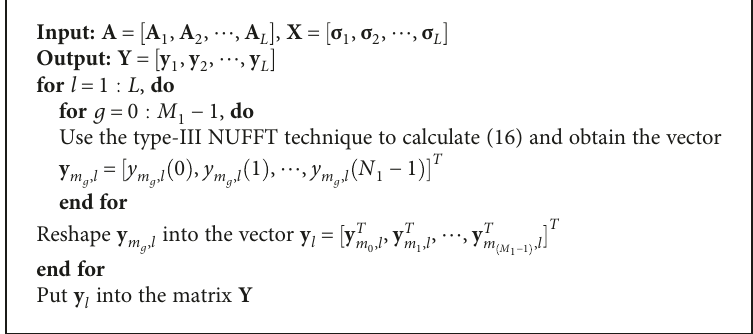
Algorithm 1: Forward function algorithm Y = g